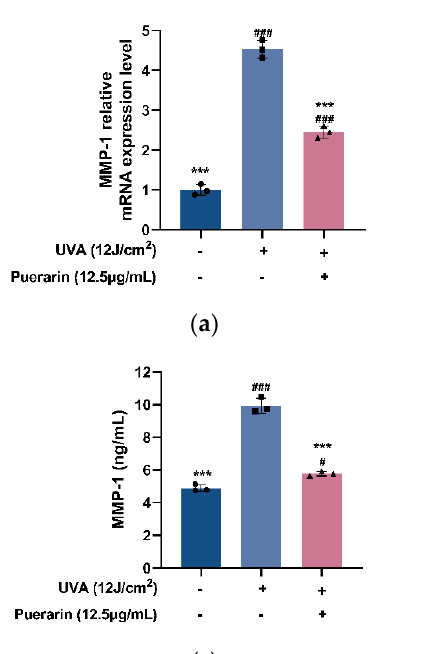
Figure 6. Effects of puerarin on UVA ‐ induced skin aging markers in HSF: ( a , b ) Effects of puerarin on MMP ‐ 1 and COL ‐ 1 expression of HSF with UVA ‐ induced oxidative damage; ( c , d ) Effects of puerarin on MMP ‐ 1 and COL ‐ 1 content of HSF with UVA ‐ induced oxidative damage. # p < 0.0 5 , ## p < 0.0 1 , ### p < 0.001 as compared to the control group; *** p < 0.001 as compared to the damage model group; Values do not have a common mark ( # , *) when p > 0.05, ( n = 3).